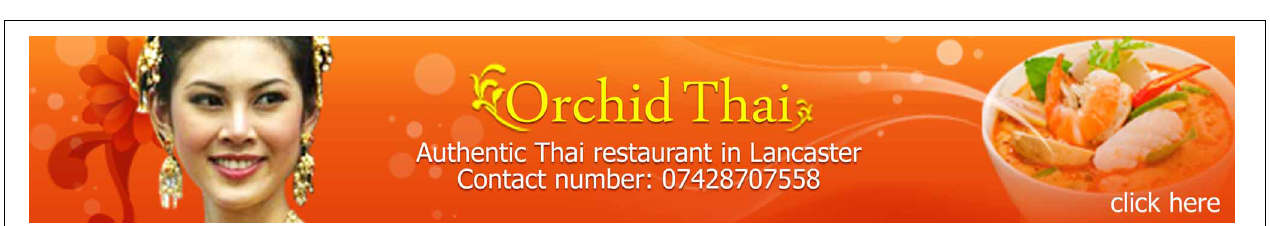
FIGURE 7 | Fabricated horizontal banner advertisement for “Orchid Thai” in the mutual gaze condition.